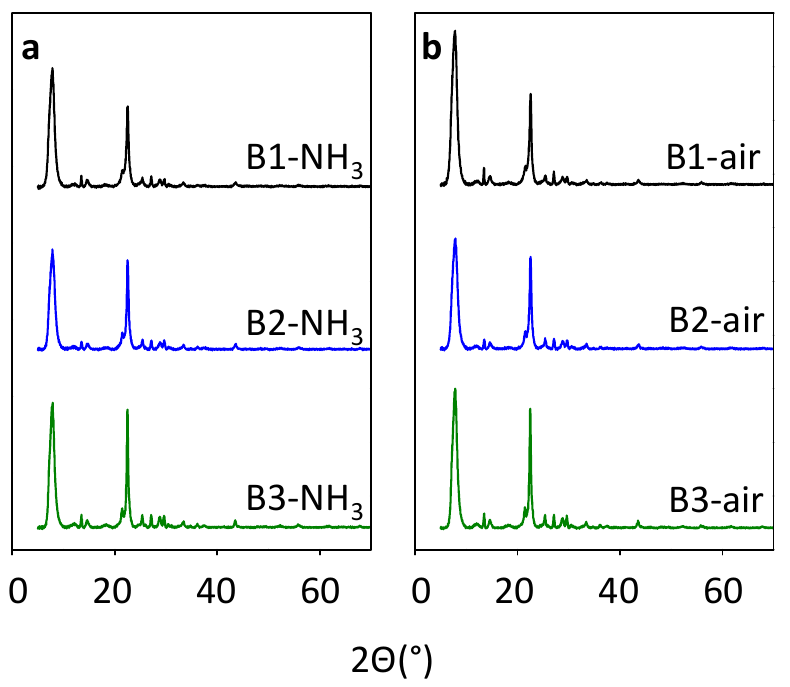
Figure 2. X ‐ ray diffraction patterns of B1–B3 samples calcined in ammonia ( a ) and in air ( b ). Figure 2. X-ray di ff raction patterns of B1–B3 samples calcined in ammonia ( a ) and in air ( b